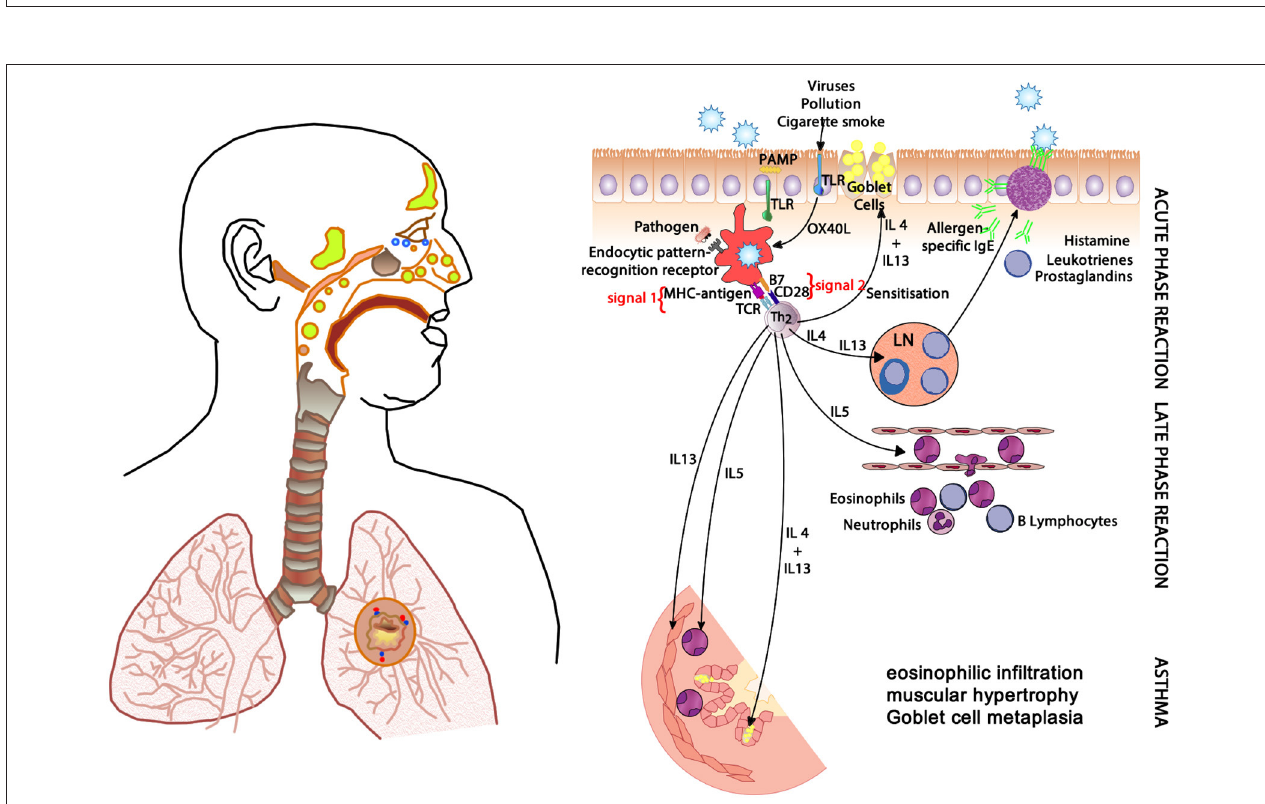
FIGURE 5 | The clinical changes and physiological mechanisms of allergic respiratory disease. Antigen-presenting cells (APCs) present allergen-derived peptides lodged within the MHC molecule to T cells within a T H 2 milieu, resulting in allergy mediated by eosinophils and IgE derived from plasma cells (transformed from activated B cells). PAMP, pathogen-associated molecular pattern; TLR, toll-like receptor; MHC, major histocompatibility complex; TCR, T cell receptor; IgE, immunoglobulin E; OX40L, CD252; B7, CD28; IL-4, interleukin-4; IL-5, interleukin-5; IL-13, interleukin-13.